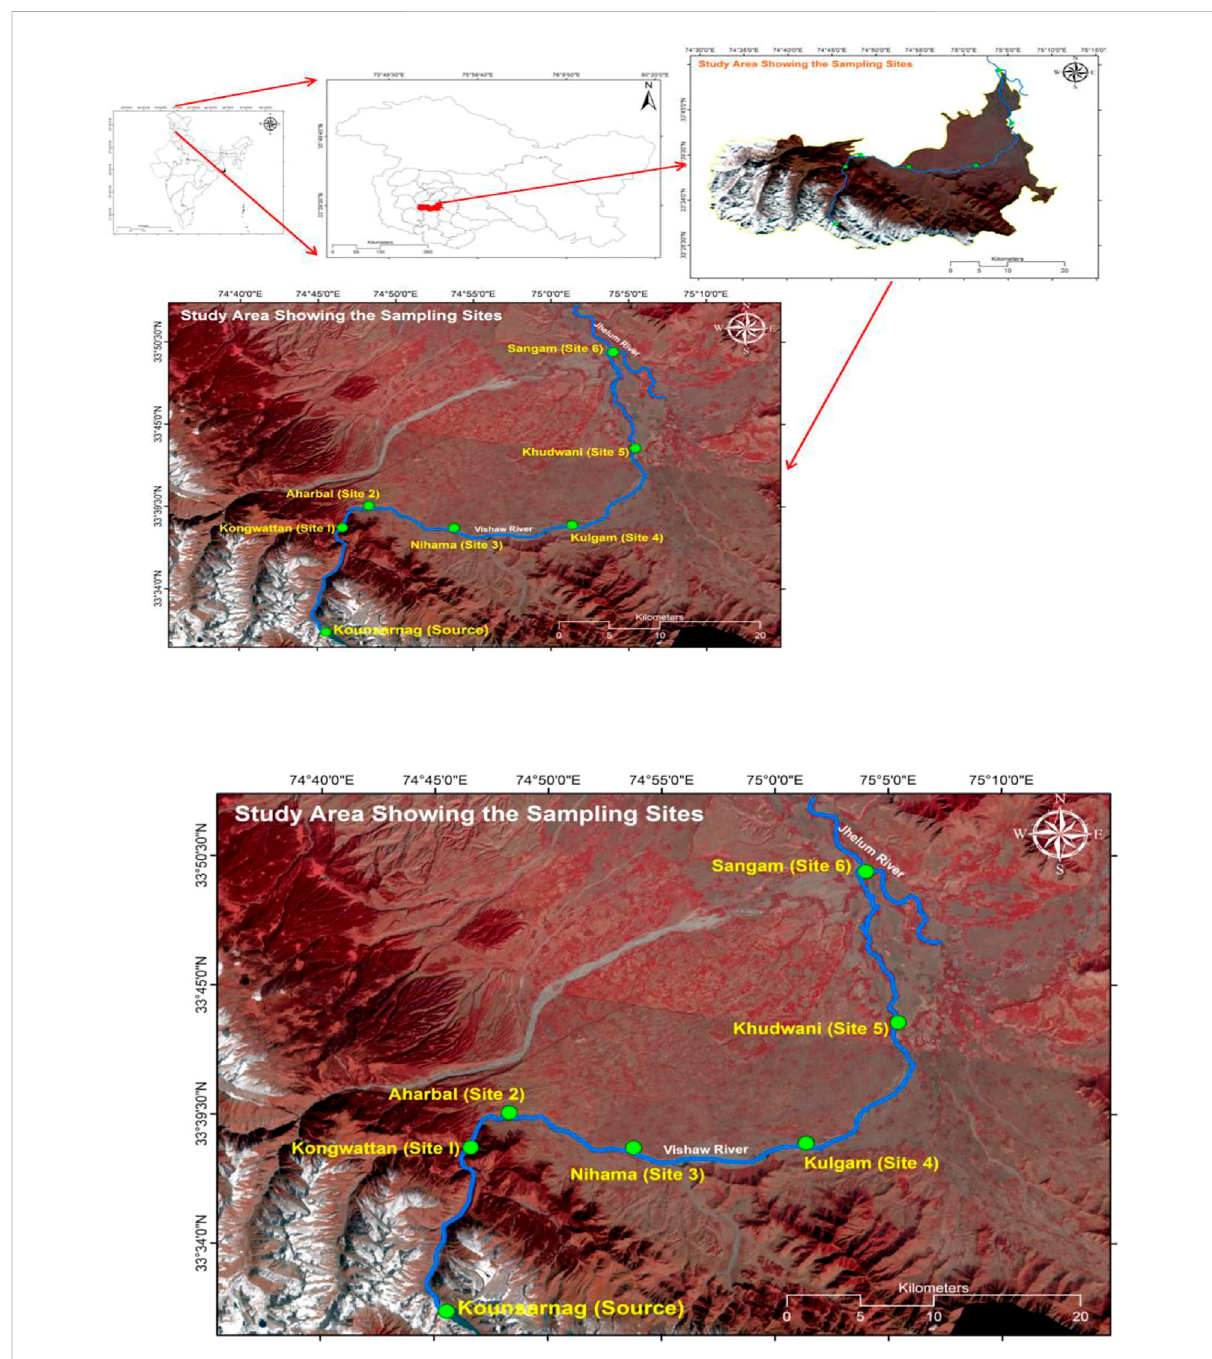
FIGURE 1 A map showing study area and sampling location of the Veshaw